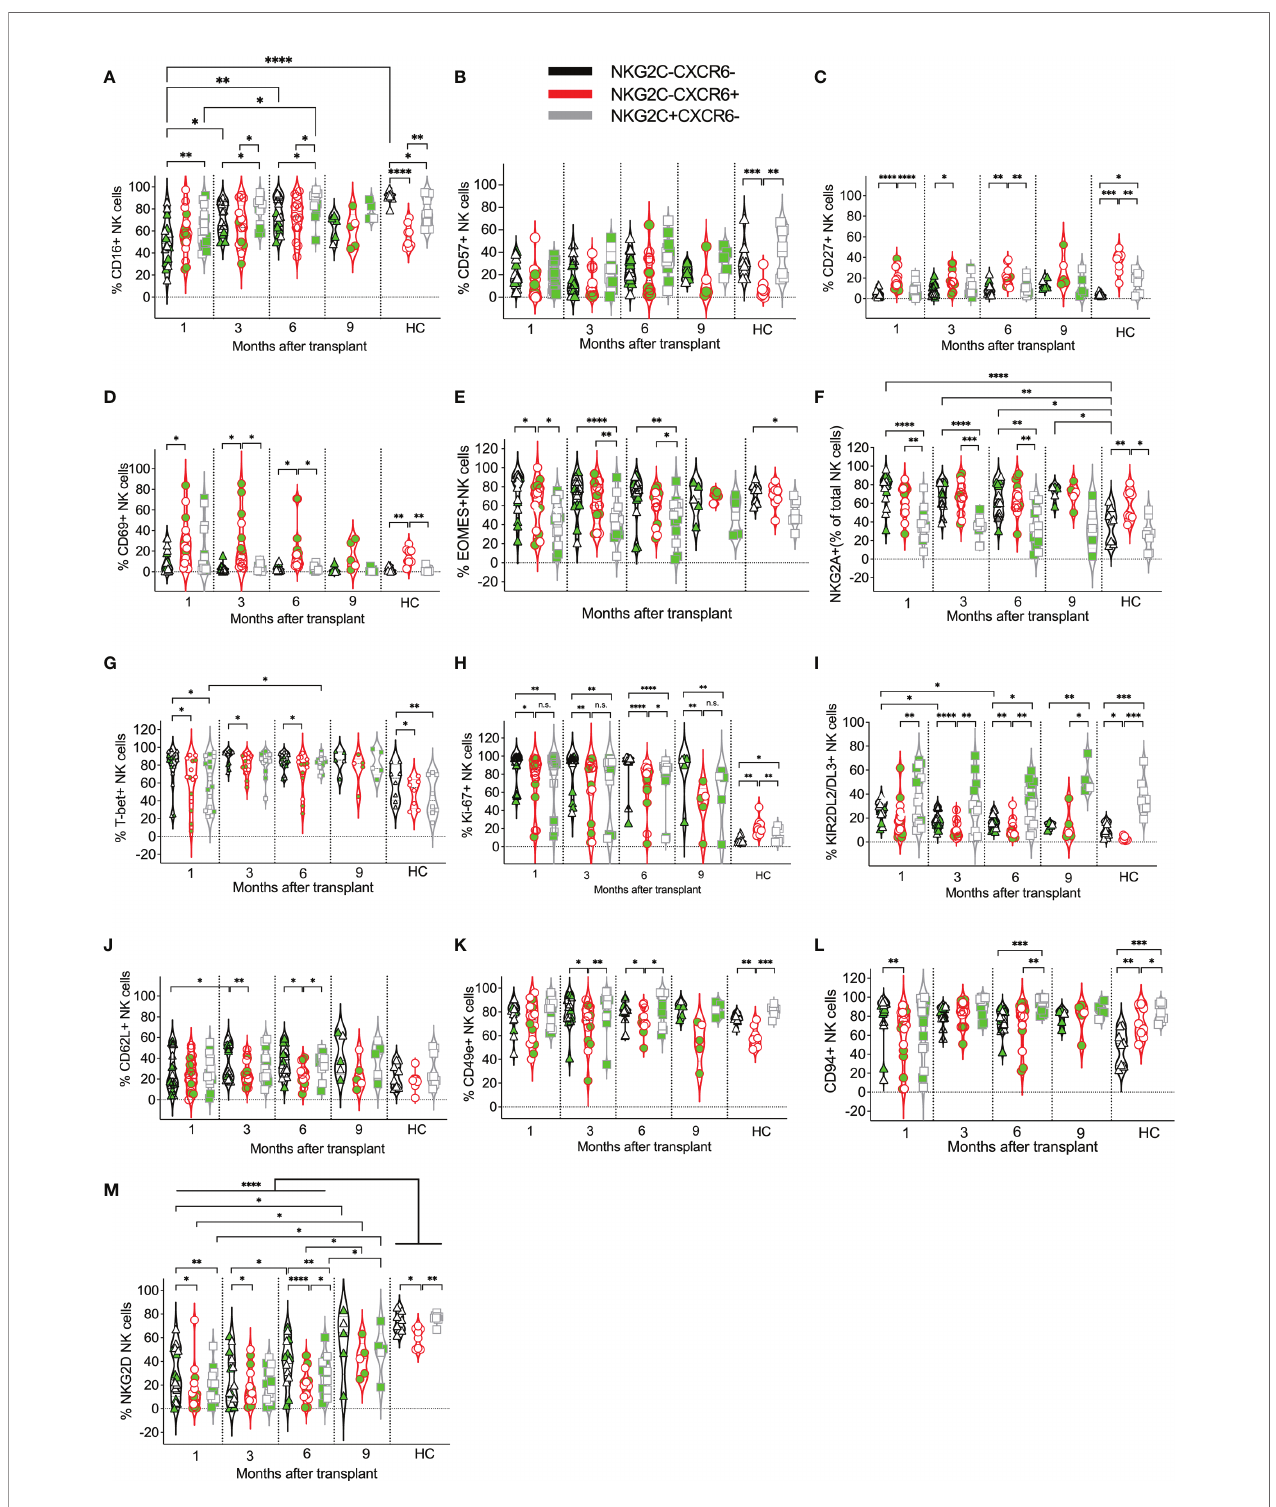
FIGURE 4 | Expressionkinetics ofdevelopmentalmarkersonCXCR6 – NKG2C – , CXCR6 + , andNKG2C + NKcells post-transplant. Thefrequenciesoftheindicated developmentalmarkers (A – M) weredeterminedfor eachpatient ’ sCXCR6 – NKG2C – , CXCR6 + , andNKG2C + NKcells attheindicatedtime points.Datapoints inblackrepresent CXCR6 – NKG2C – NKcells; datapointsinredrepresentCXCR6 + NKcells,anddatapointsingrayrepresentNKG2C + NKcells. Circulating healthyadultdonor NKcellswerealso analyzedasacontrol. Eachdatapointrepresents asingletransplantrecipientor healthyadult controldonor (HC). Datapointswitha neon-green fi llcolorrepresentpatients positivefor CMVupto andat theanalysistimeas determinedbyquantitatePCR. *p<0.05;**p< 0.005; ***p<0.0005;****p<0.0005; Notsigni fi